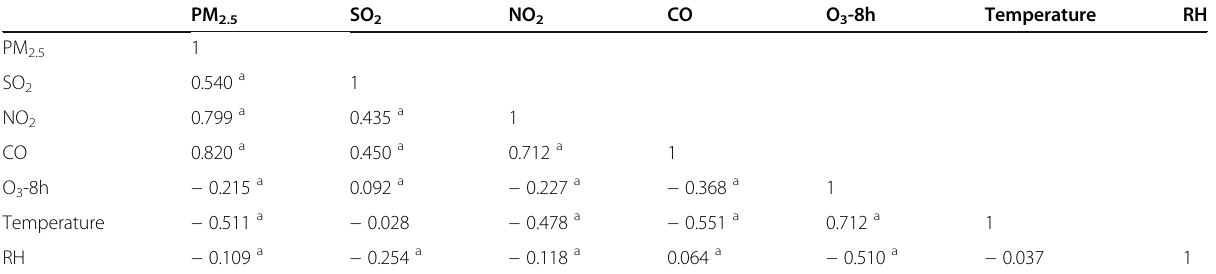
Table 2 Spearman ’ s correlation coefficients of air pollutants and weather conditions PM 2.5